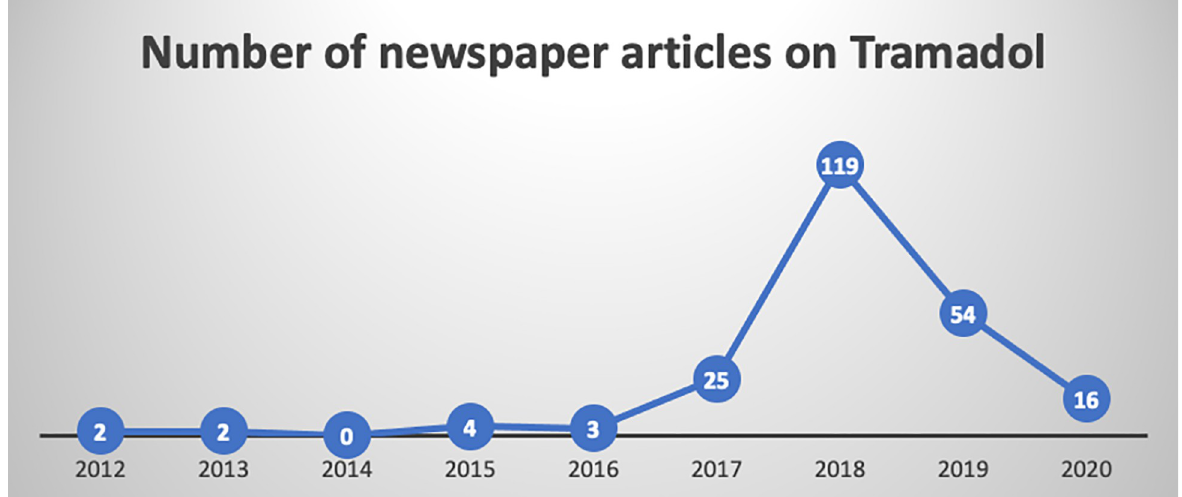
Fig 1. Evolving trends in newspaper reports on tramadol in Ghana. Source: Author.